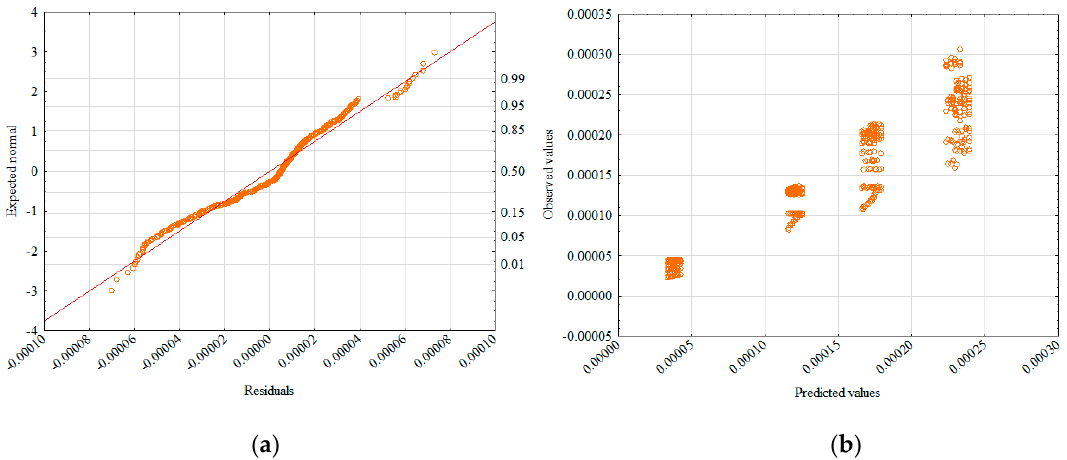
Figure 8. Normality diagram of residuals ( a ) and values observed against predicted ( b ).